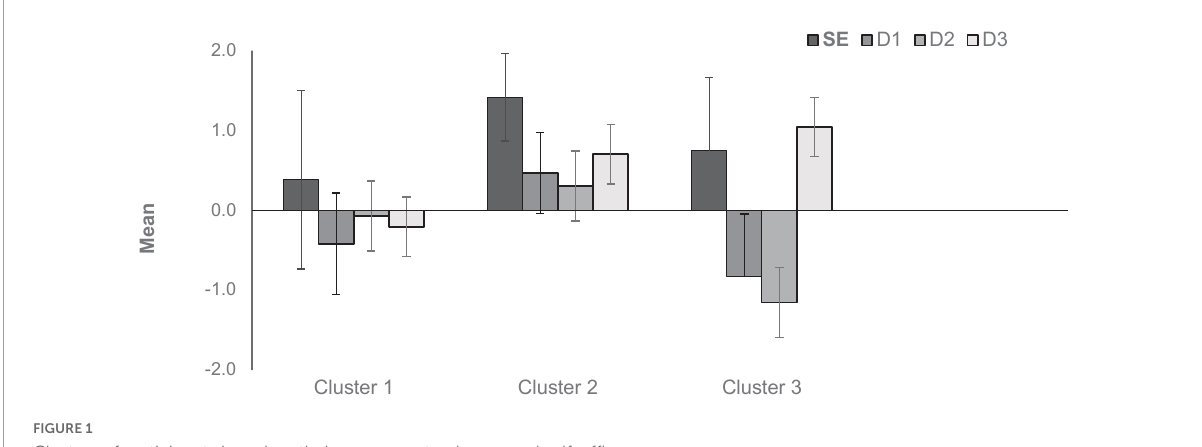
FIGURE1 Clusters of participants based on their responses to change and self-efficacy.